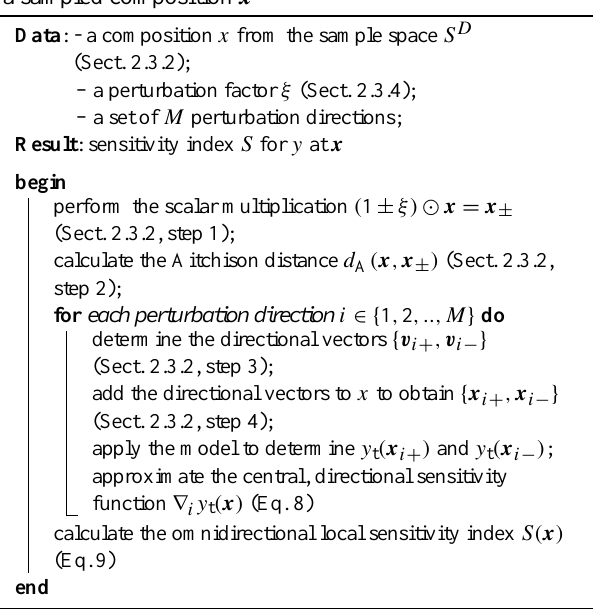
Algorithm 1 : Calculate the local sensitivity index S for a sampled composition